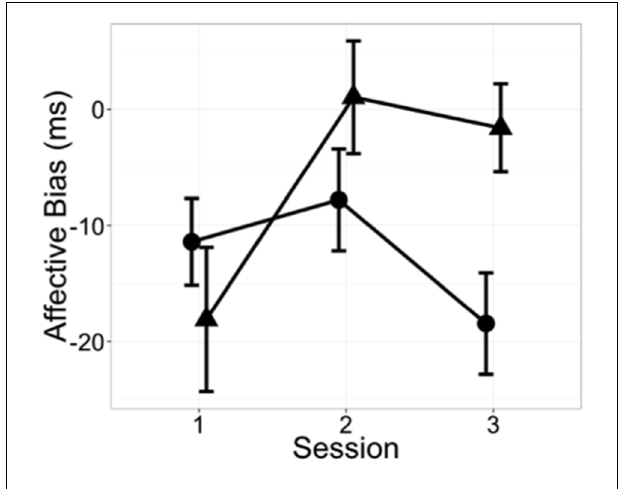
FIGURE 2 |Affective bias changed in tai chi students compared to control subjects. Specifically, reaction times to positive and negative valenced words tended to equalize in tai chi students over time ( p = 0.008, linear mixed effects model group x session interaction).Test sessions conducted at (1) beginning, (2) middle, and (3) end of semester. • = control subjects; (cid:2) = tai chi students. Mean ± SEM. Bias = positive valence reaction time–negative valence reaction time.